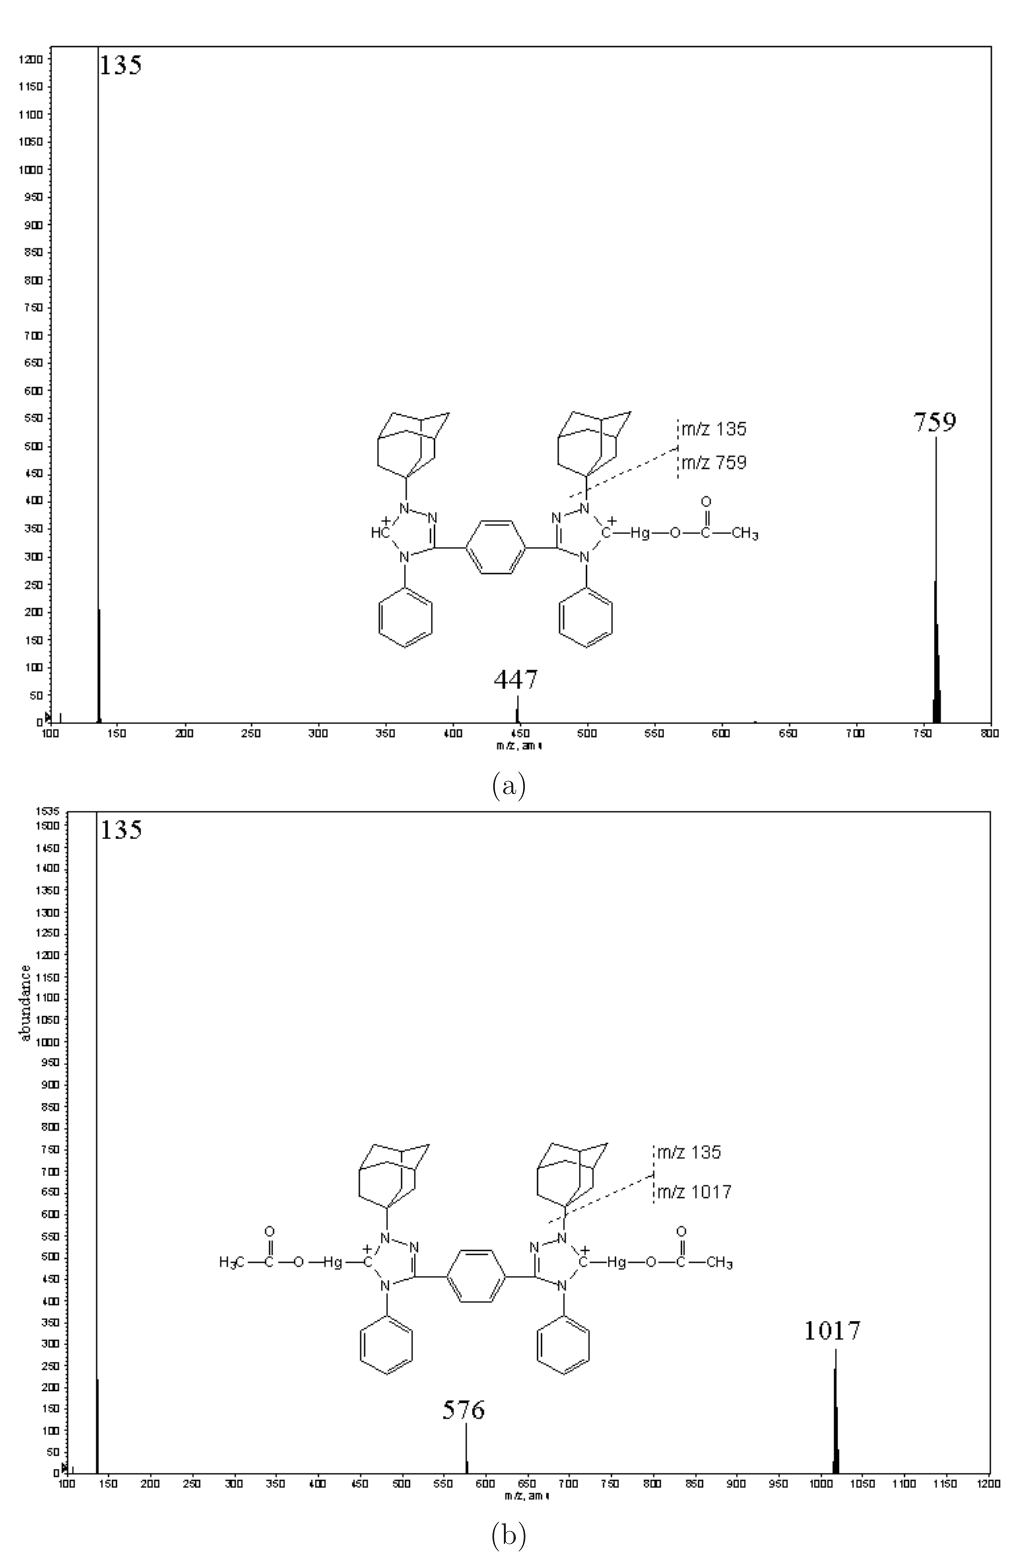
Fig. 3 MS/MS spectrum of [ 5 +H+HgOOCCH 3 ] +2 at m/z 447 (a, collision energy 20 eV) and [ 5 +2HgOOCCH 3 ] +2 at m/z 576 (b, collision energy 20